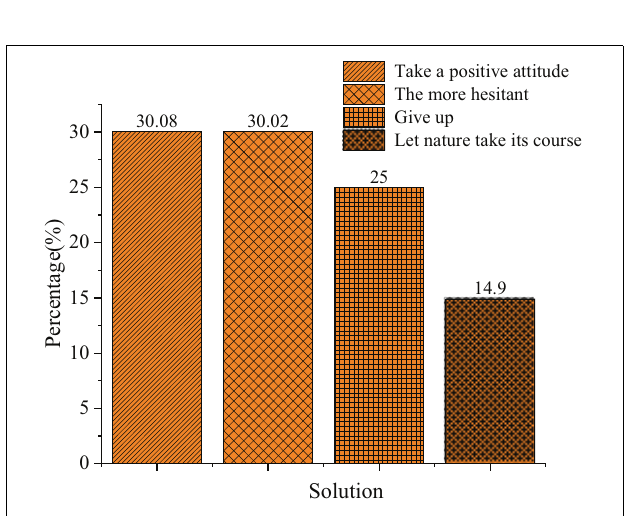
FIGURE 6 | Importance of entrepreneurial